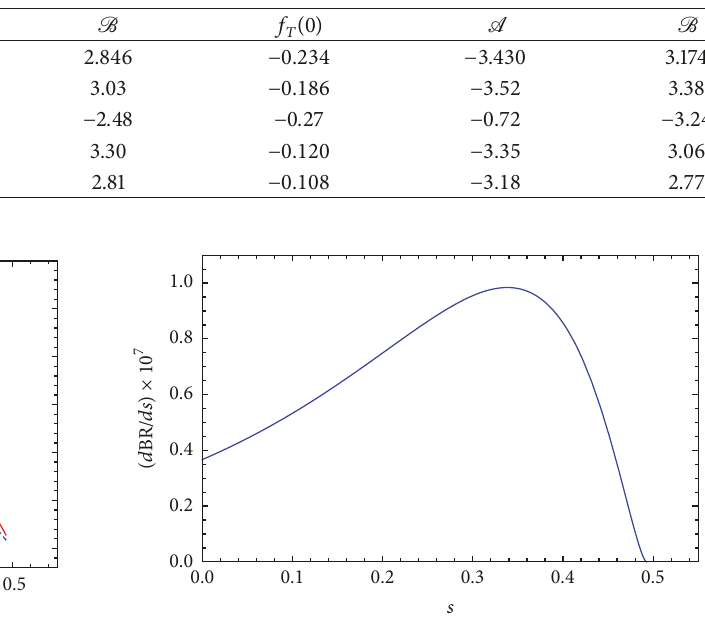
Table 1: Form factors for 𝐵 + 푐 → 𝐷 + ]] decay process at 𝑞 2 = 0 and the parameters A and B defined by (17) and their comparison with other theoretical model predictions.